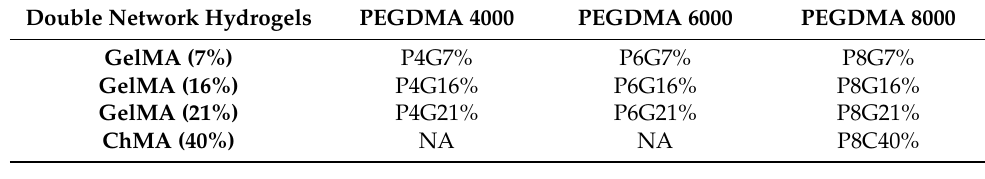
Table 1. Nomenclature of Double Network hydrogels.